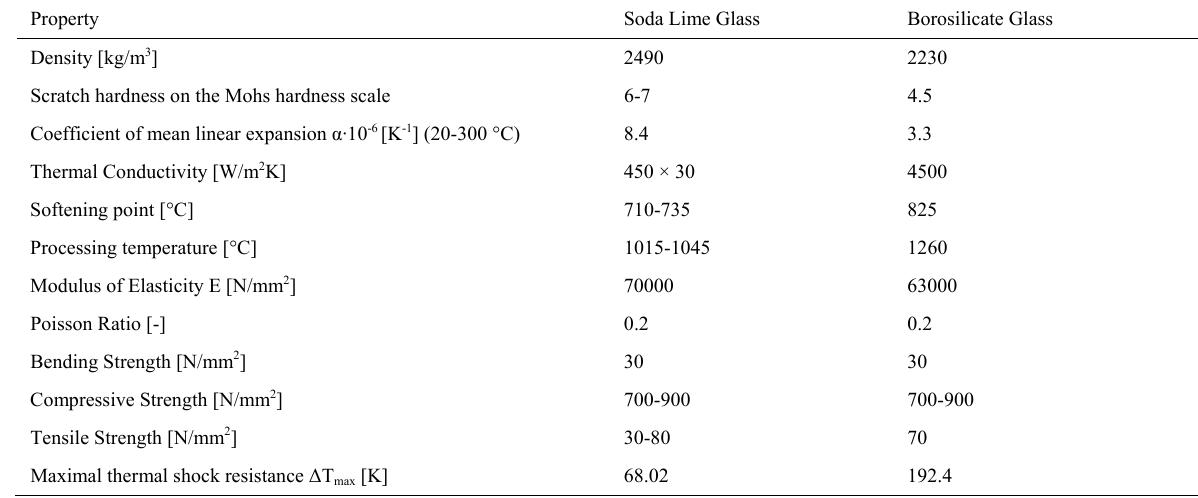
Table 1: Material properties for soda lime silicate and borosilicate as obtained from (Petzold et al.,